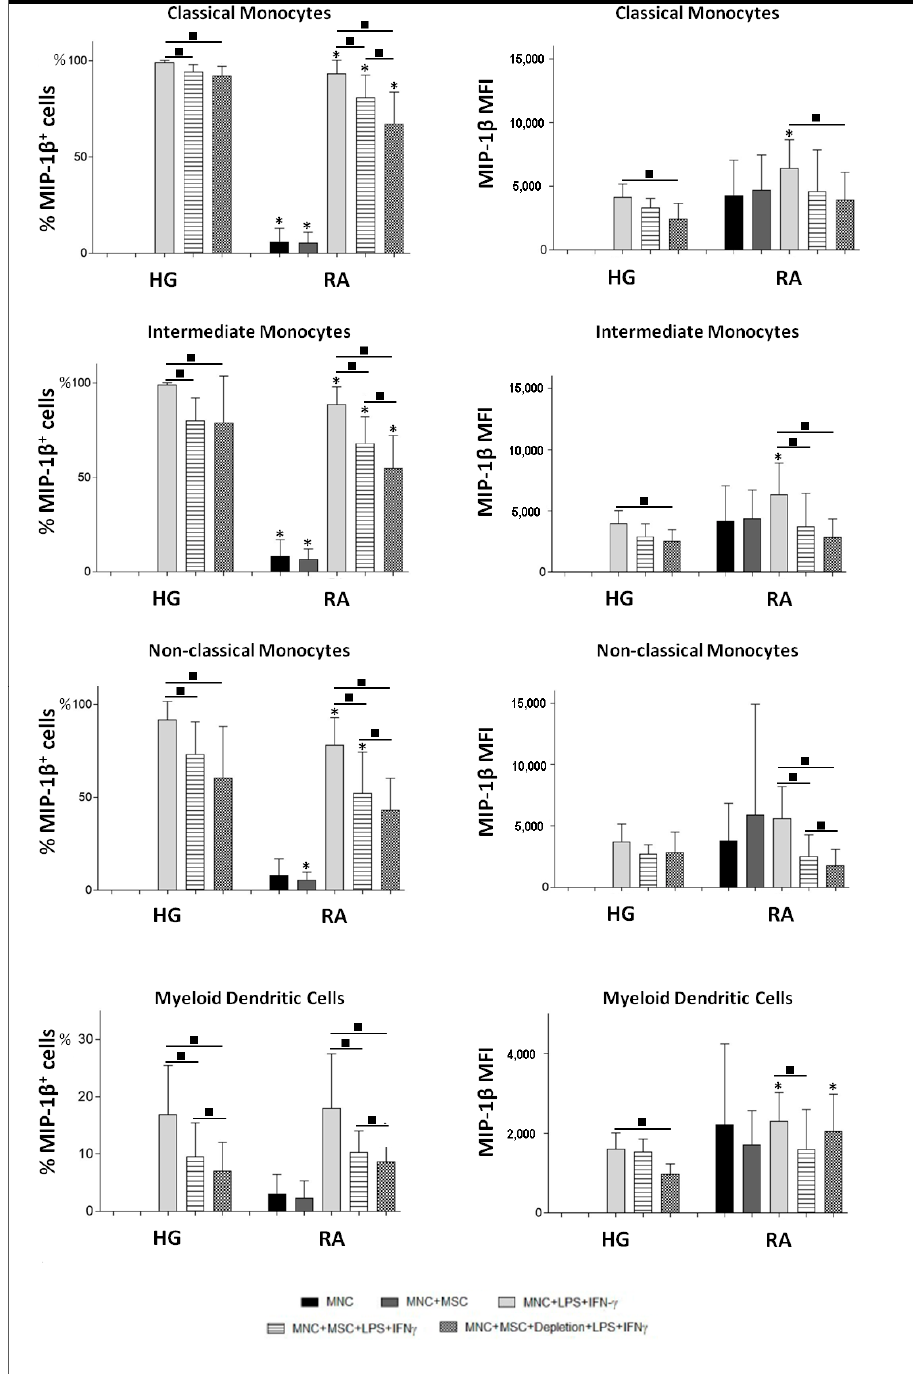
Figure 4. MIP-1 β protein levels in monocytes and mDCs from RA patients and healthy